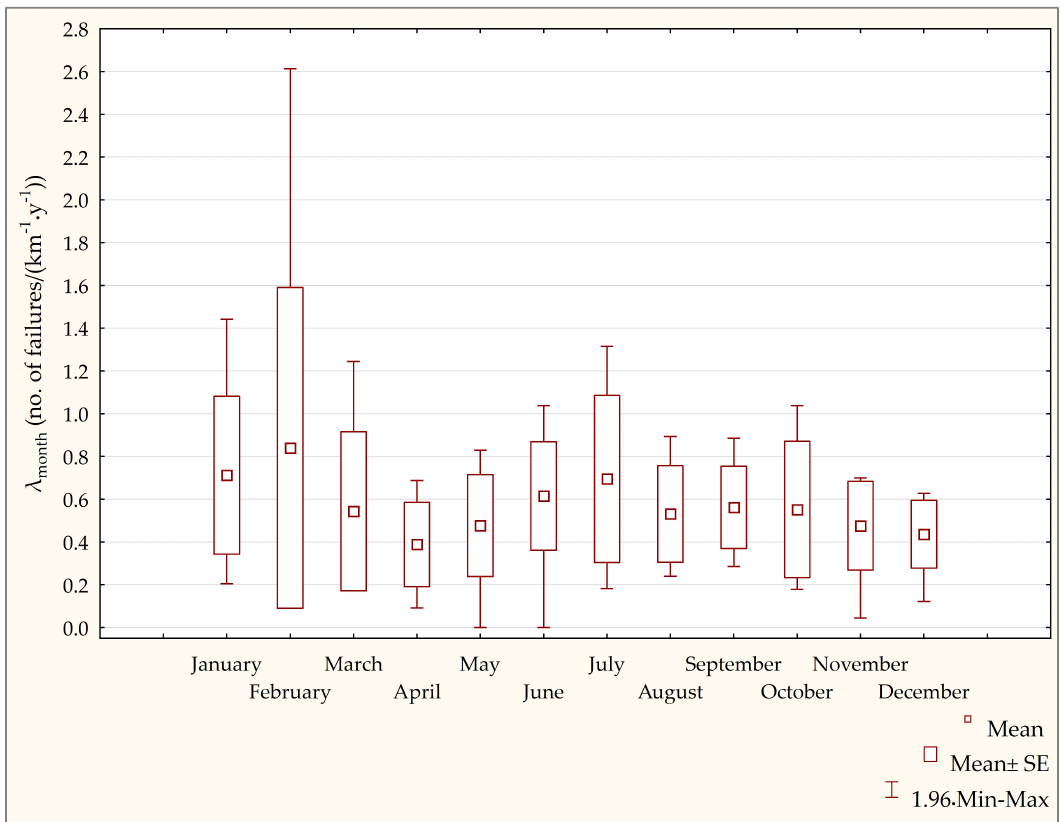
Figure 6. A box-whisker plot of the mean values for failure rates along the WDN in each month of the year and in line with the following operational data for the 2005–2017 period.